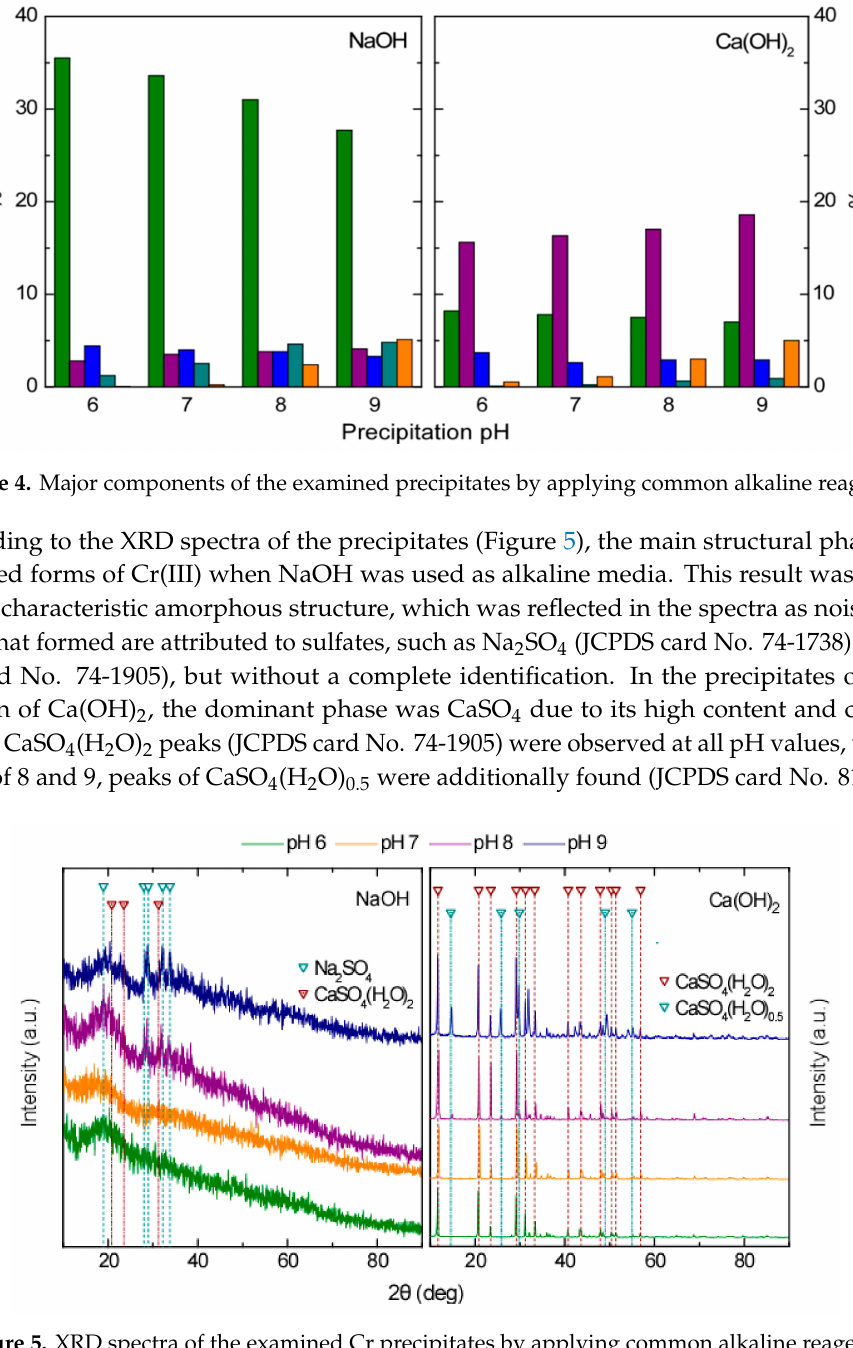
Figure 5. XRD spectra of the examined Cr precipitates by applying common alkaline